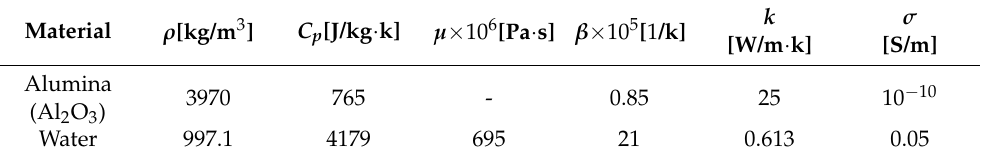
Table 1. Material properties at a temperature of 293 K. Reprinted/adapted with permission from Ref. [52]. Elsevier,